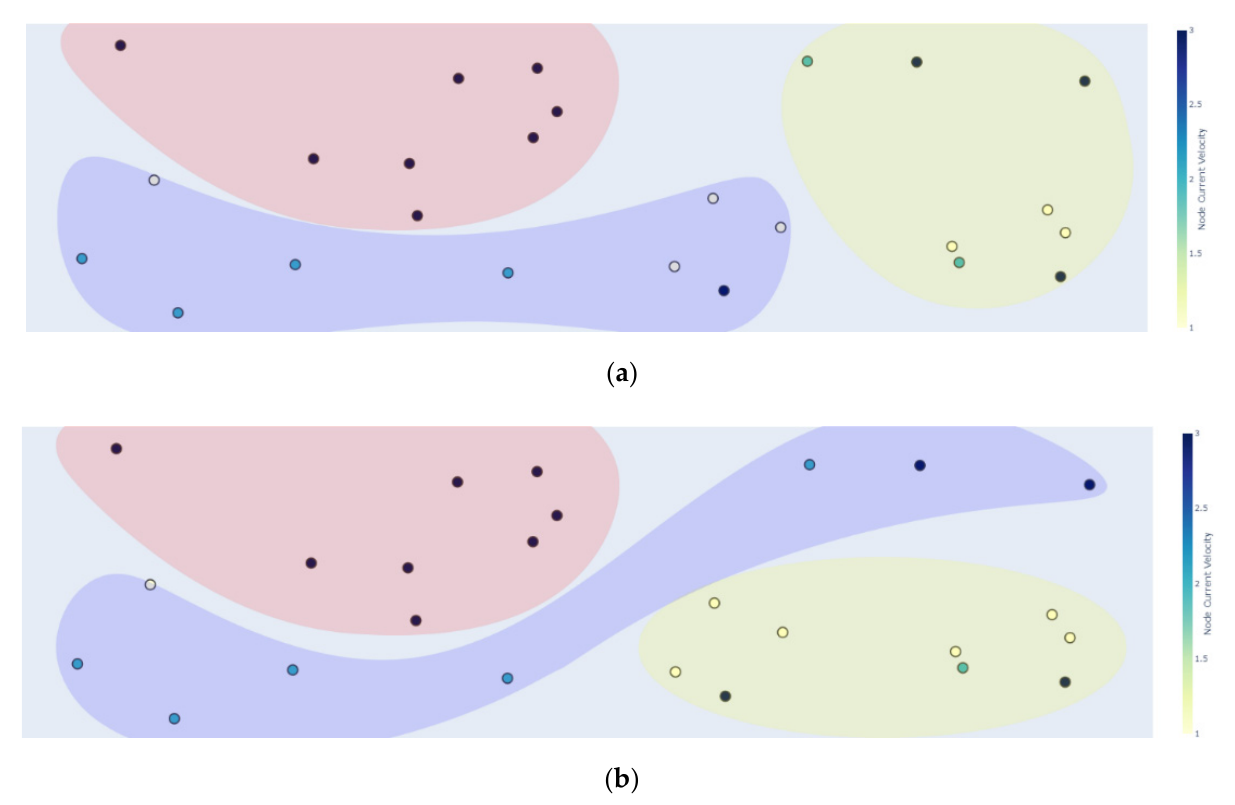
Figure 7. Clustering results of case study 2 with Mini Batch K-Means and Ward Clustering ( a ) and Birch ( b ).